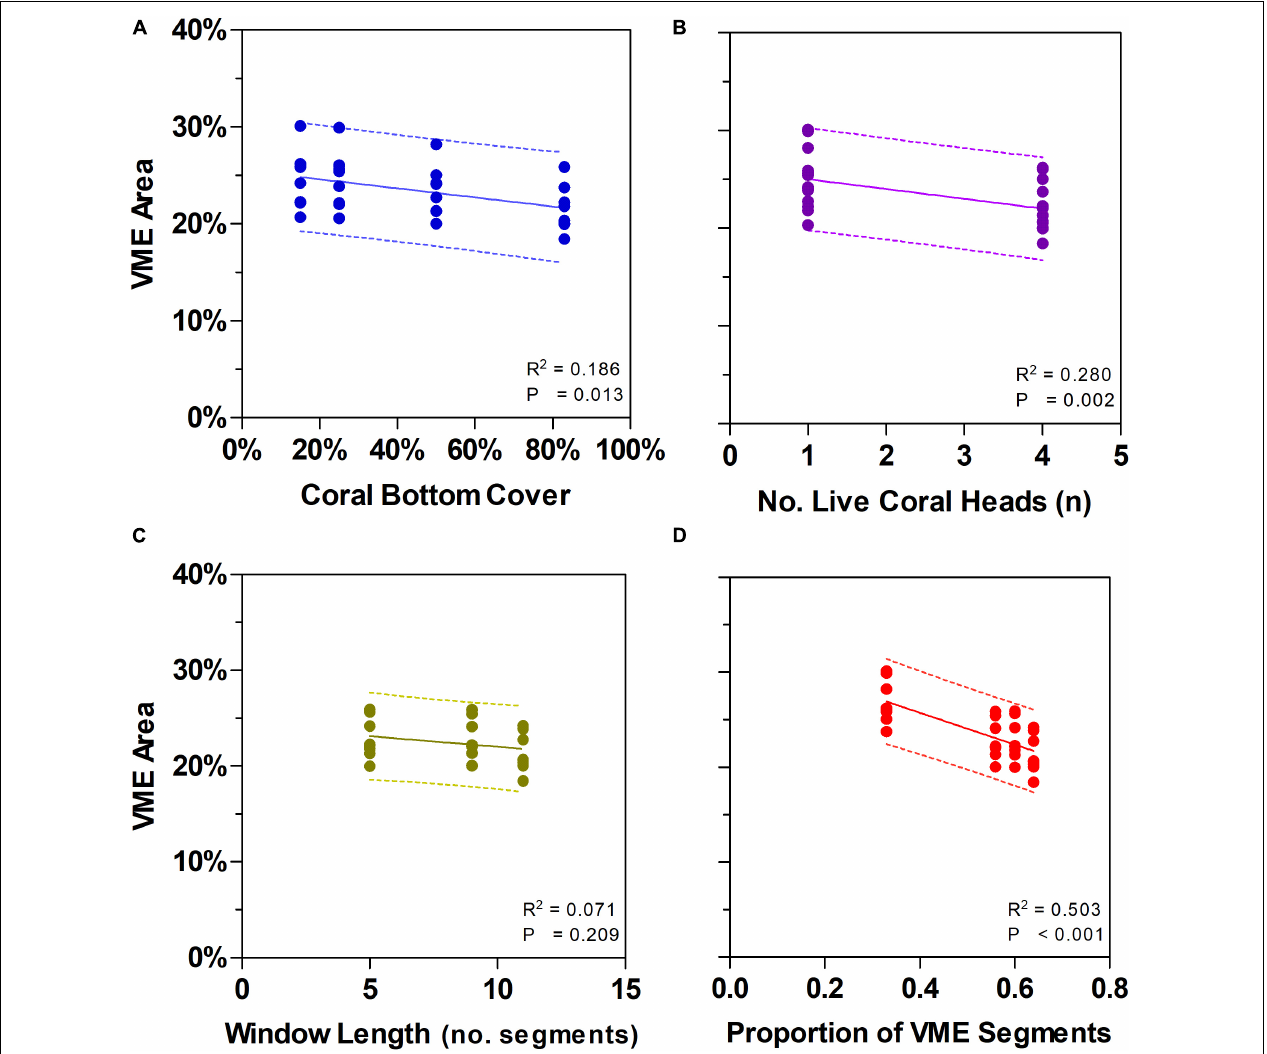
FIGURE 7 | Effects of changing some key parameters in scenario modeling to gauge the sensitivity of a method to classify areas of deep seabed as vulnerable marine ecosystems (VME). Top row shows how changes in the criteria of bottom cover by stony corals (A) and the number of live coral heads per segment (B) influence the proportion of the sampled seabed that is classed as VME based on individual segments. Bottom row shows how segments along transect lines can be aggregated into patches using a moving window that can vary in length (C) and in the proportion of segments having to meet the criteria under (A) and (B) above inside a window (the ratio) (D) . Panel (C) shows the effect of varying window length with similar ratio ( ∼ 3:5, 5:9, 7:11); panel (D) includes window with a small ratio